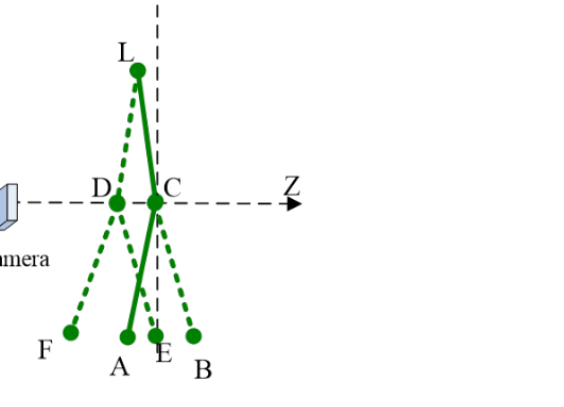
Figure 4. Heuristic search for reverse joint correction. C and D are dual points, i.e., the 3D distance from L is the same to D or to C; in addition, C and D can project to the same position on 2D camera